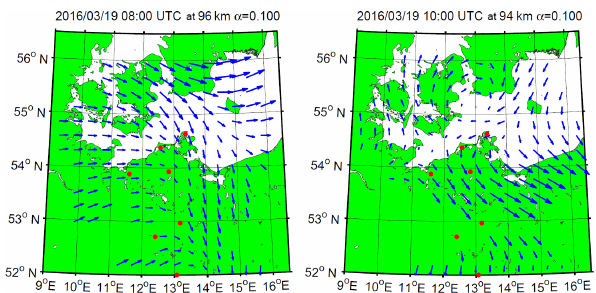
Figure 12. Two examples of obtained wind fields showing a small vortical structure above the Baltic coast and a potential body force of a breaking GW.